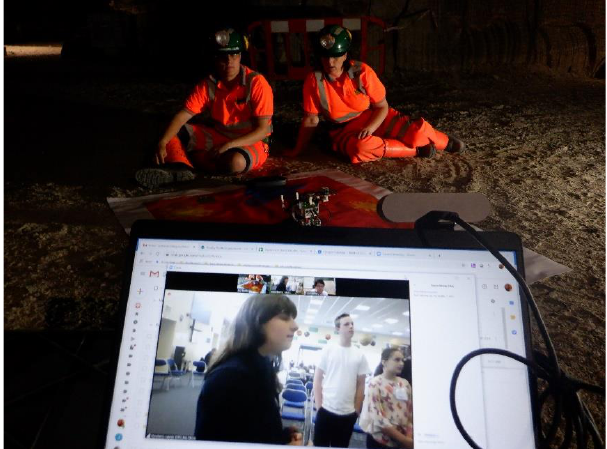
Fig. 3. The 2019 pilot event for Remote 3 , participants are watching their remote rover in the Mars Yard.